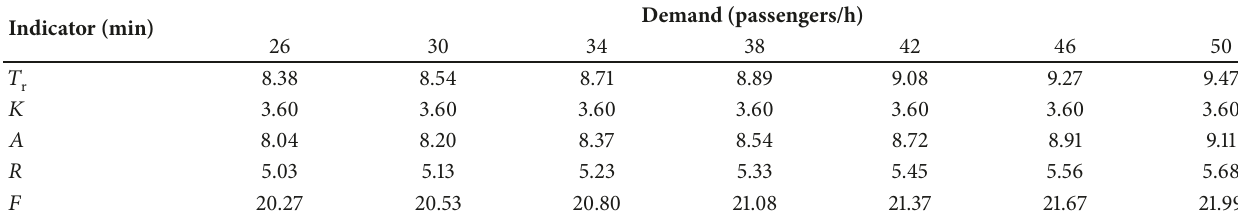
Table 2: Passenger cost indicators in route deviation service ( 𝛼 =0.1 and 𝛽 =0.1).